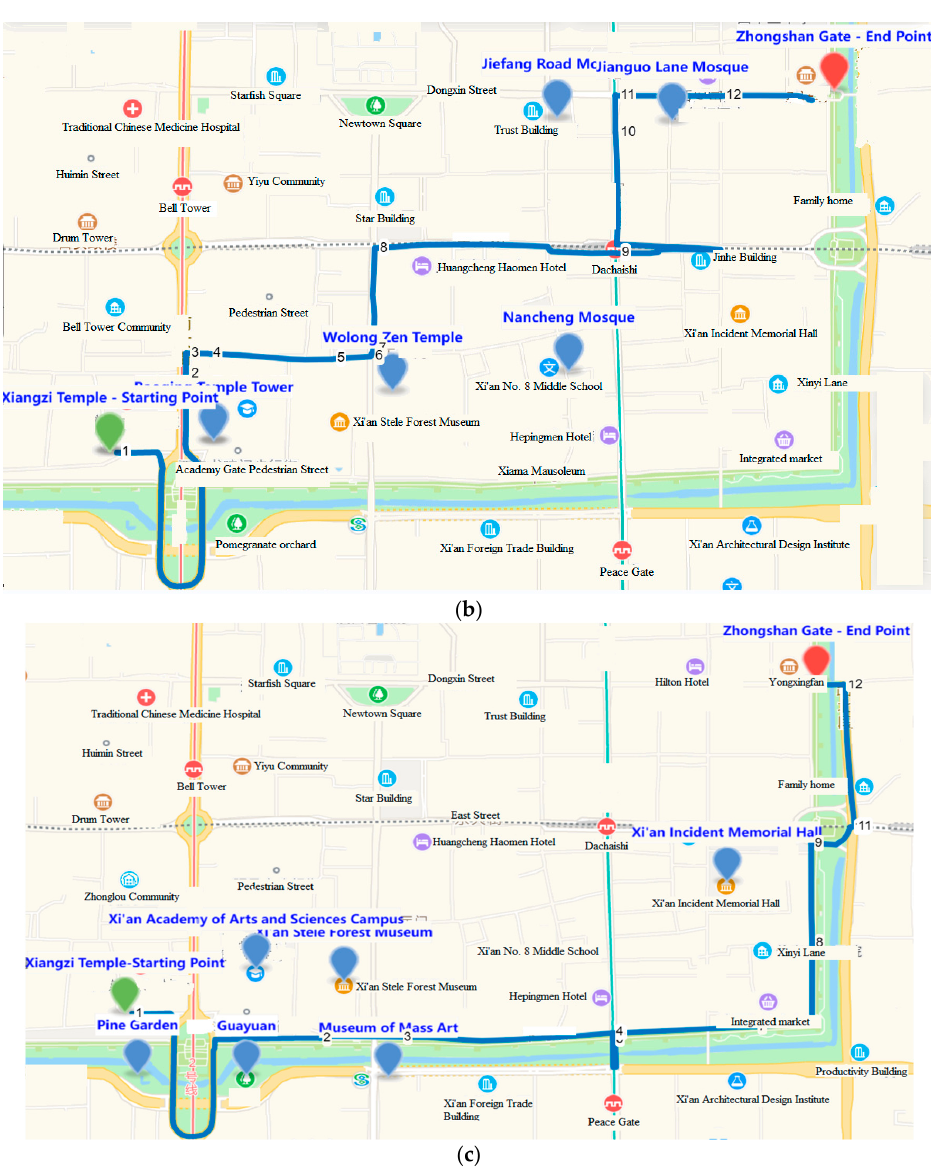
Figure 14. Visualization results of users u 1 , u 2 , and u 3 path data. ( a ) u1; ( b ) u2; ( c ) u3. In Figure 14b, user u2 passes through the “Baoqing Temple Tower”, “Wolong Zen Temple”, “Nancheng Mosque”, “Jiefang Road Mosque”, and “Jianguo Lane Mosque” along the way. These POIs have religious, scenic, characteristic buildings, and other char- acteristics, which are in line with user u2’s interests and preferences. In Figure 14c, user u3 passes through the “Xi’an Academy of Arts and Sciences Cam- pus”, “Pine Garden”, “Guayuan”, “Xi’an Stele Forest Museum”, “Museum of Mass Art”, and “Xi’an Incident Memorial Hall” along the way. The “Pine Garden” is rich in vegeta- tion, clean in environment, and adjacent to the moat and ancient city wall. The “Pome- granate Garden” displays the cultural characteristics of the “Silk Road”. While exhibiting Xi’an’s culture, it has also become a “city complex” integrating culture, tourism, com- merce, and life.